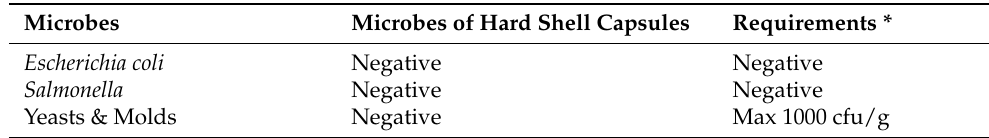
Table 3. Microbial measurement of hard-shell capsules. Microbes Microbes of Hard Shell Capsules Requirements * Escherichia coli